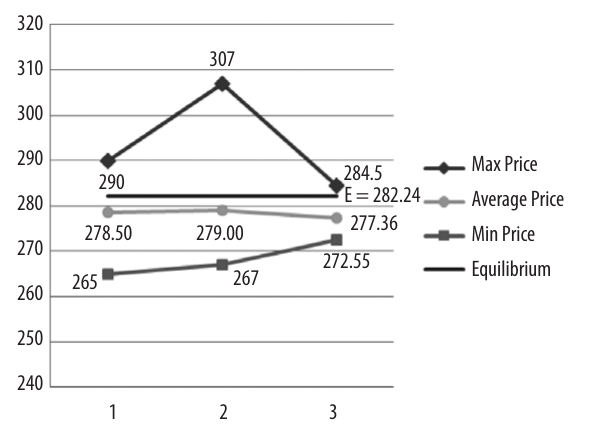
Fig 2. Final prices of Game 1 for each